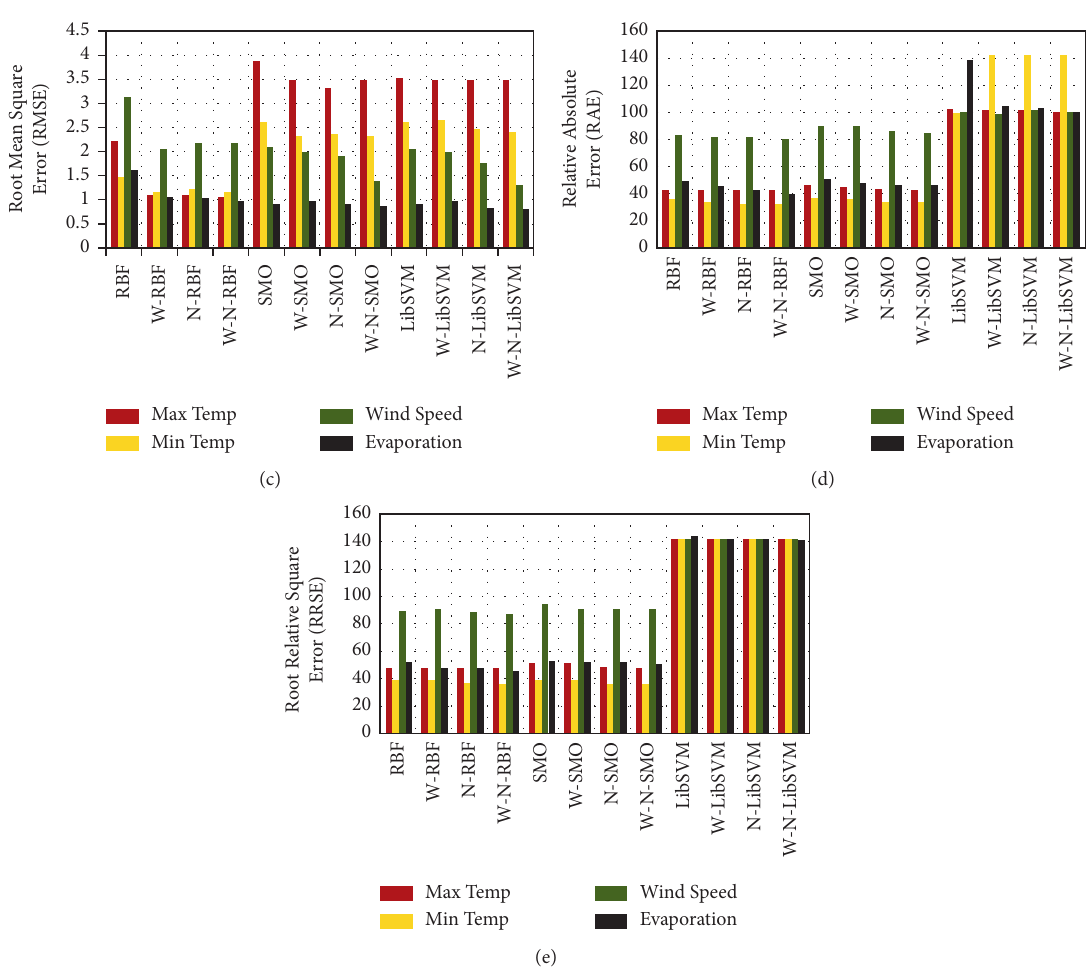
Figure 6: Comparison plot of forecasting errors for Delhi data. (a) TTcomparison. (b) MAE comparison. (c) RMSE comparison. (d) RAE comparison. (e) RRSE comparison.